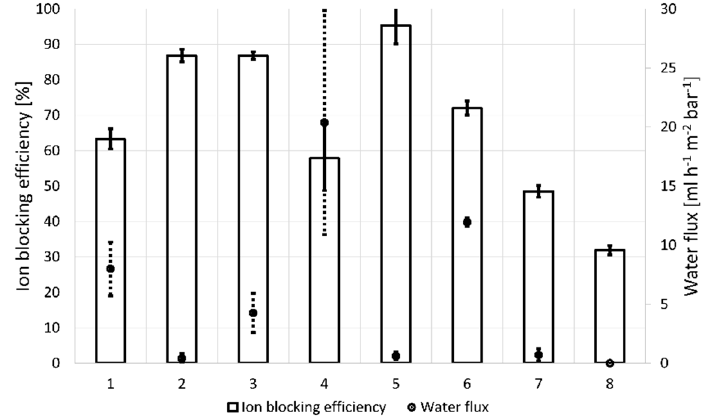
Figure 5. Forward osmosis test result, water flux, and ions blocking efficiency.